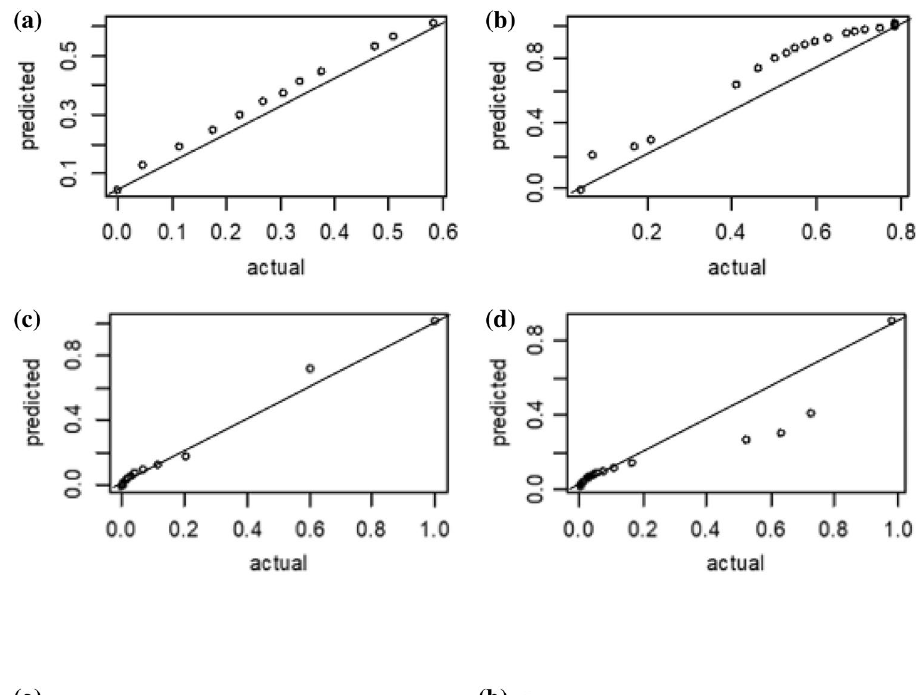
Fig. 6 Actual vs predicted value for deep neural networks model with a wetting phase relative permeability for validation set, b wetting phase relative perme- ability for test set, c non-wetting relative permeability for valida- tion set, d non-wetting relative permeability for the test